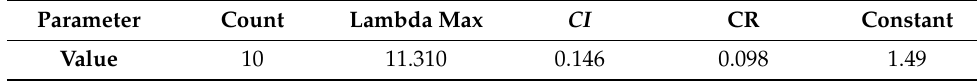
Table 7. Summary of the calculation of the AHP parameters.